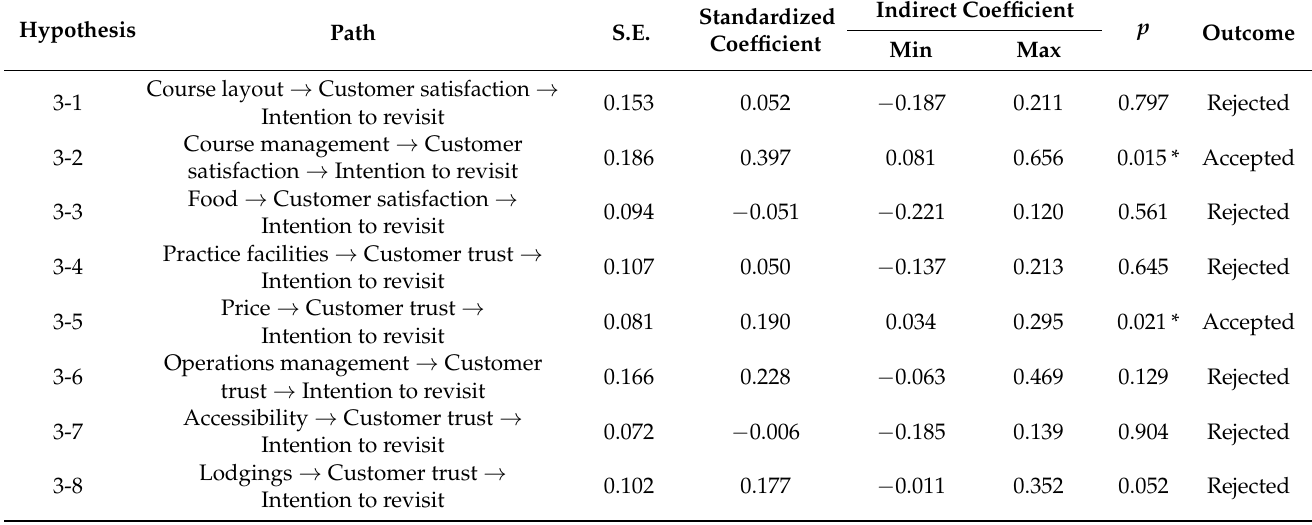
Table 10. Results for